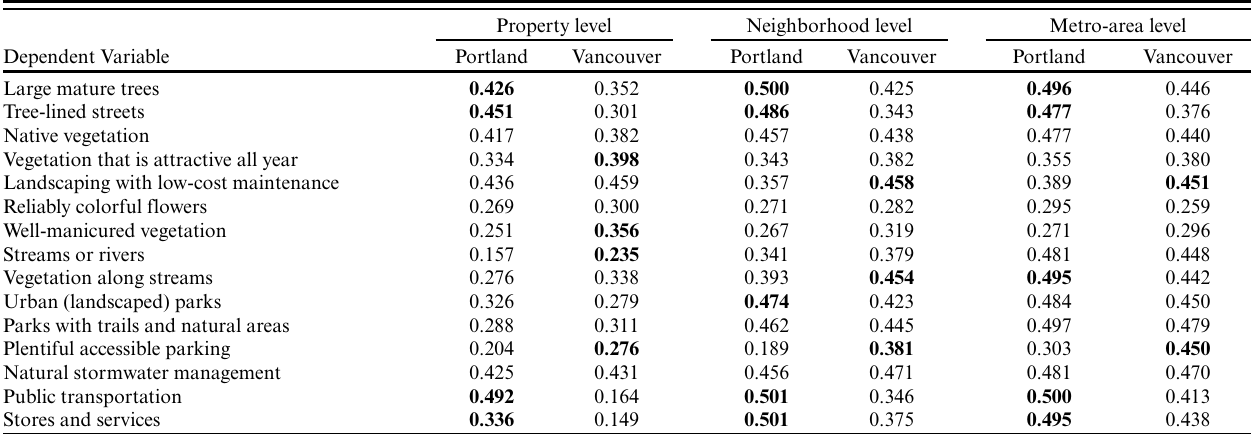
Table 5 . Indicator analysis illustrating trends in divergence† between cities and across three scales for landscape